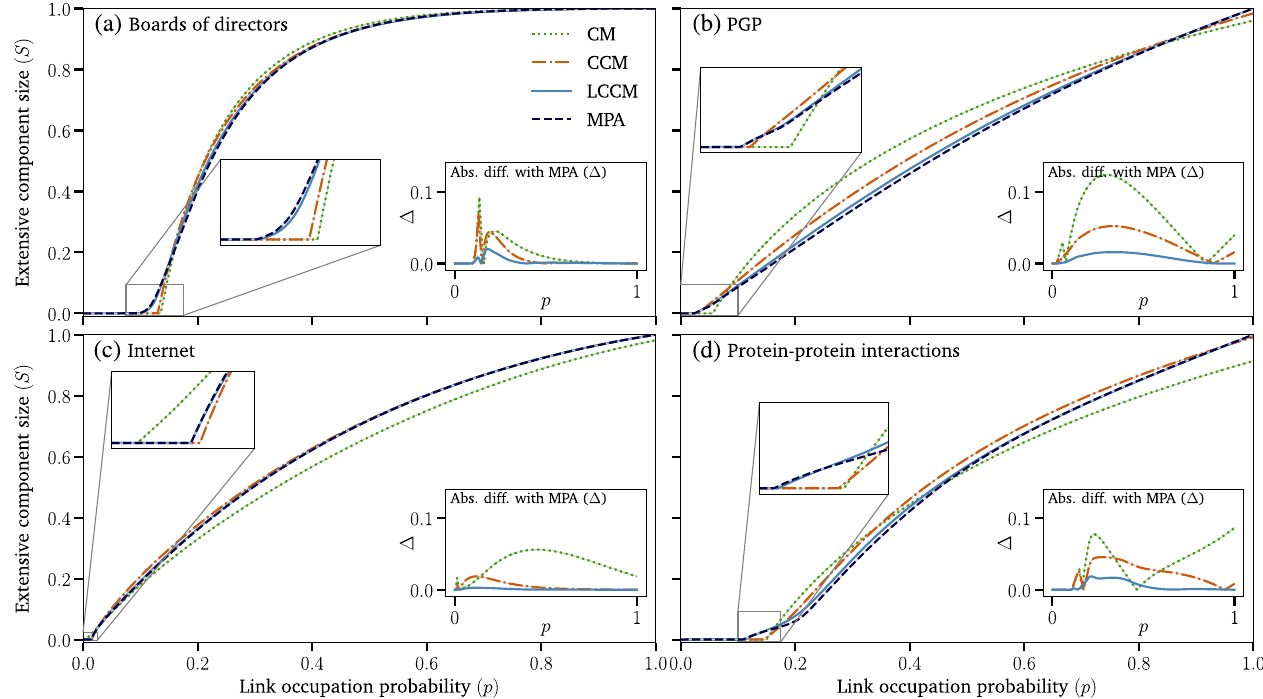
FIG. 4. Relative size of the extensive component predicted by the LCCM with the CM, the CCM, and the MPA for four representative real network datasets. (a) One-mode projection of a bipartite network of Norwegian boards of directors [23]. (b) PGP web of trust [24]. (c) A subset of the Internet at the autonomous level [25]. (d) Protein-protein interaction network of Homo sapiens [26]. The insets show the absolute value of the difference Δ between the MPA and the CM, the CCM and the LCCM as a function of p , as well as an enlargement of the region around the percolation threshold. The largest connected component was used for all